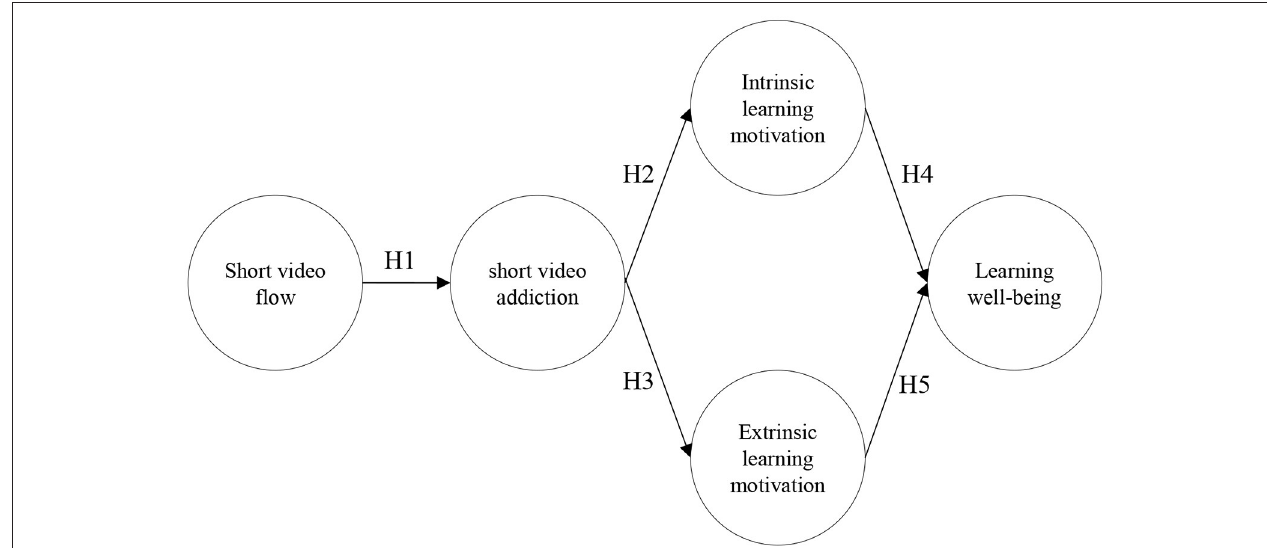
FIGURE 1 | Research